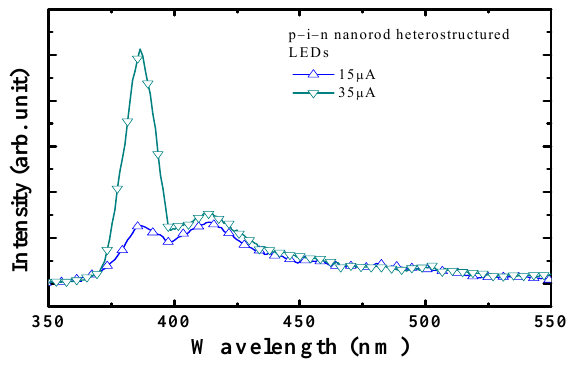
Figure 25. Room temperature EL spectra of the ZnO nanorod based heterostructured p-i-n light-emitting